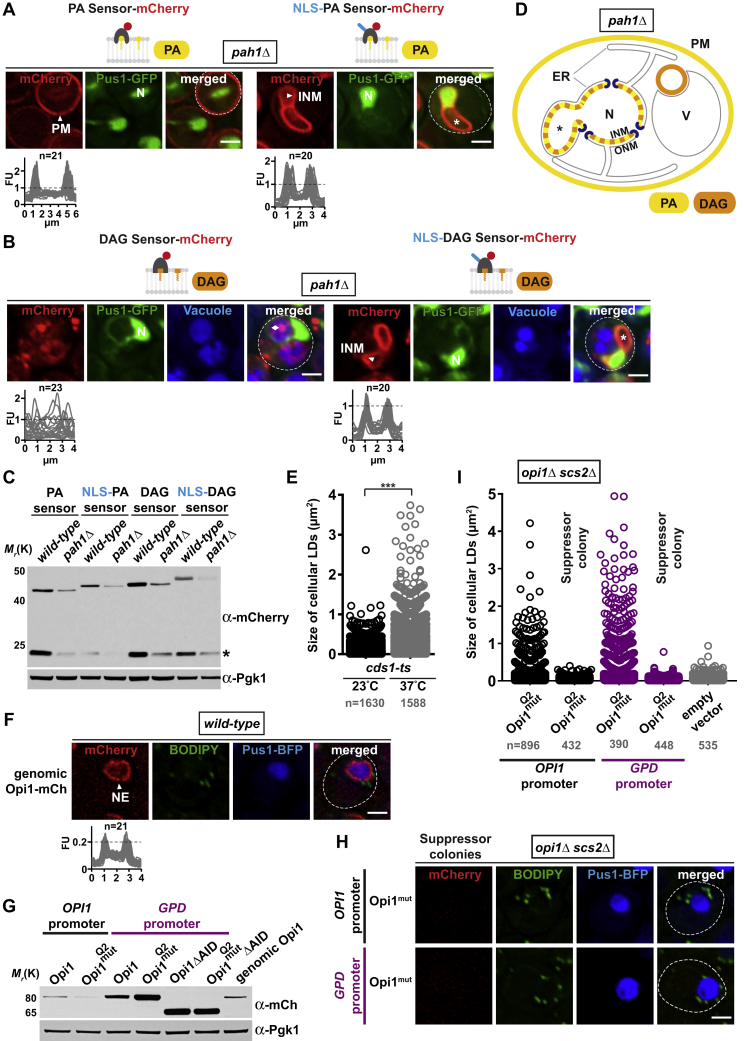
NE Growth Is Linked to an Increase of Phosphatidic Acid at the INM, Related to Figure 1, 6, 7, and Discussion(A) Live imaging of pah1Δ cells expressing the indicated plasmid-based PA-mCherry sensors and the genomically integrated nucleoplasmic marker Pus1-GFP. PAH1 deletion induces nuclear membrane proliferation and nuclear expansion, which can lead to the engulfment of cytoplasmic material (marked by asterisk) as shown by the absence of Pus1 staining and earlier studies (Santos-Rosa et al., 2005). Line-scans were generated across the whole cell (left) or the nucleus (right). n indicates the number of randomly selected cells, y axis: Arbitrary Fluorescence Units, FU; x axis: distance in μm. For comparison the FU value 1 is marked with a horizontal dashed line. Plasma membrane, PM; nucleus, N; inner nuclear membrane, INM. Scale bar: 2 μm.(B) Live imaging of the indicated DAG sensors in pah1Δ cells. DAG sensor-reactive material (diamond), which often overlapped with the vacuole and may represent aberrant membrane structures, is frequently seen in pah1Δ cells. Vacuoles are stained with CellTracker Blue. Line-scans were generated across the vacuole (left) or the nucleus (right). Inner nuclear membrane, INM; nucleus, N. Asterisk indicates NE expansion. Scale bar: 2 μm.(C) Sensor protein levels were analyzed in wild-type and pah1Δ cells. Denaturing extracts were prepared and immunoblotted with an anti-mCherry antibody directed against the sensors and with an anti-Pgk1 antibody as a loading control. Sensor expression was reduced in the pah1Δ mutant. Asterisk indicates degradation product.(D) Schematic localization of major PA and DAG pools in pah1Δ cells as detected by lipid biosensors. Asterisk marks NE expansion. DAG-positive structures of unknown origin overlap with vacuoles. Inner nuclear membrane, INM; outer nuclear membrane, ONM; nucleus, N; endoplasmic reticulum, ER; plasma membrane, PM; vacuole, V.(E) Automated quantification of lipid droplet size in cds1-ts cells grown at 23°C or 37°C for 4 hours. After setting identical fluorescence intensity thresholds, circular BODIPY structures were automatically selected and quantified in ImageJ. Number of analyzed cells is indicated. p value (∗∗∗ < 0.001) was determined by Wilcoxon signed-rank test.(F) Live imaging of wild-type cells expressing genomically integrated Opi1-mCherry and plasmid-based Pus1-BFP. Lipid droplets are stained with BODIPY. The subcellular distribution of genomically expressed Opi1 is indistinguishable from plasmid-based Opi1. Opi1 interacts with the ER-protein Scs2 and labels mostly the NE. Line-scans quantify the fluorescent intensity across the nucleus. n indicates the number of randomly selected cells, y axis: Arbitrary Fluorescence Units, FU; x axis: distance in μm. The FU value 0.2 is marked with a horizontal dashed line. Nuclear envelope, NE. Scale bar: 2 μm.(G) Protein levels of the indicated plasmid-based Opi1-mCherry constructs expressed from different promoters in opi1Δ scs2Δ cells. Opi1 is expressed at similar levels from its genomic locus or from a plasmid harboring the endogenous OPI1 promoter. Denaturing extracts were prepared and immunoblotted with an anti-mCherry antibody for Opi1 and with an anti-Pgk1 antibody as a loading control.(H) Characterization of fast-growing genetic suppressors, which emerged in the opi1 Q2 mutant when expressed from the endogenous OPI1 promoter (lane 2, -Ino, Figure 7D) or the stronger GPD promoter (lane 4, -Ino, Figure 7D). Individual colonies were picked from the plate and analyzed by fluorescent microscopy. Suppression of the growth defect likely stems from acquired mutations that abolish Opi1-mCherry expression as shown by the lack of mCherry fluorescence. Scale bar: 2 μm.(I) Automated quantification of lipid droplet size in (H) shows that suppression of the Opi1 Q2 mutant growth defect correlates with a reduction of cellular LD size. Suppressor colonies were compared to the respective Opi1 Q2 mutants shown in Figure 7B and an empty vector control. After setting identical fluorescence intensity thresholds for all experiments, circular BODIPY structures were automatically selected and quantified in ImageJ. Number of analyzed cells is indicated.